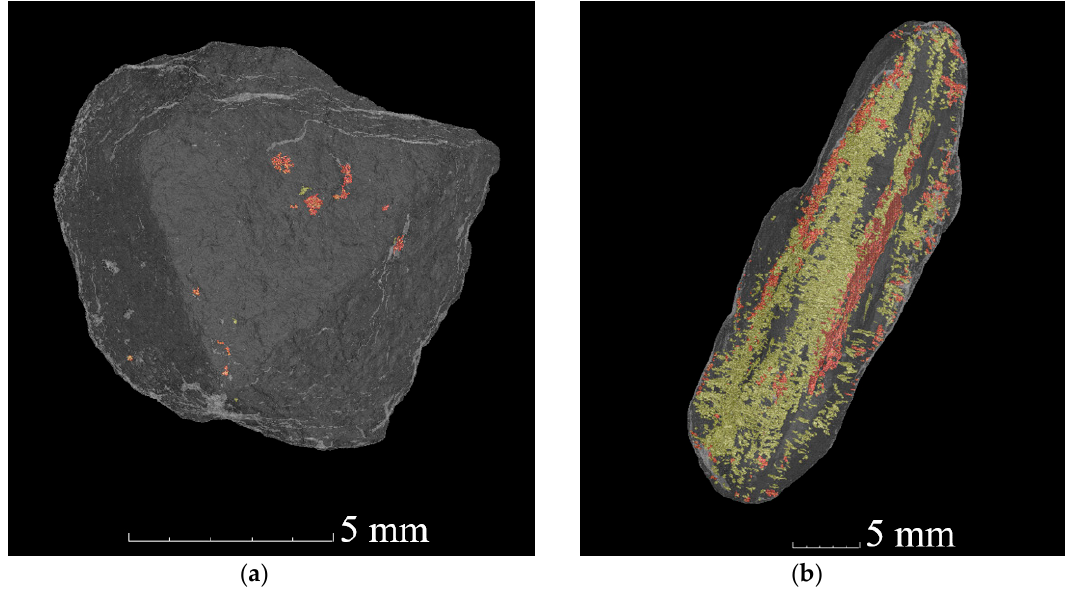
Figure 15. Example images of cracking within a quarried greywacke aggregate ( a ) and a river-gravel type greywacke aggregate ( b ). Red pixels denote externally accessible cracks/pores and yellow pixels denote externally inaccessible (closed) cracks/pores (reproduction of figures from [10,11]).